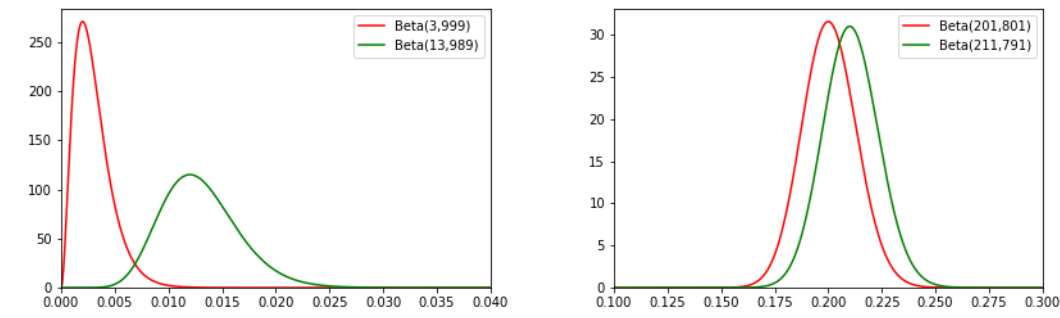
Figure A1. The overlap of probability density functions of the Beta functions corresponding to p A and p B in Case (a) ( left ) and Case (b) ( right ).